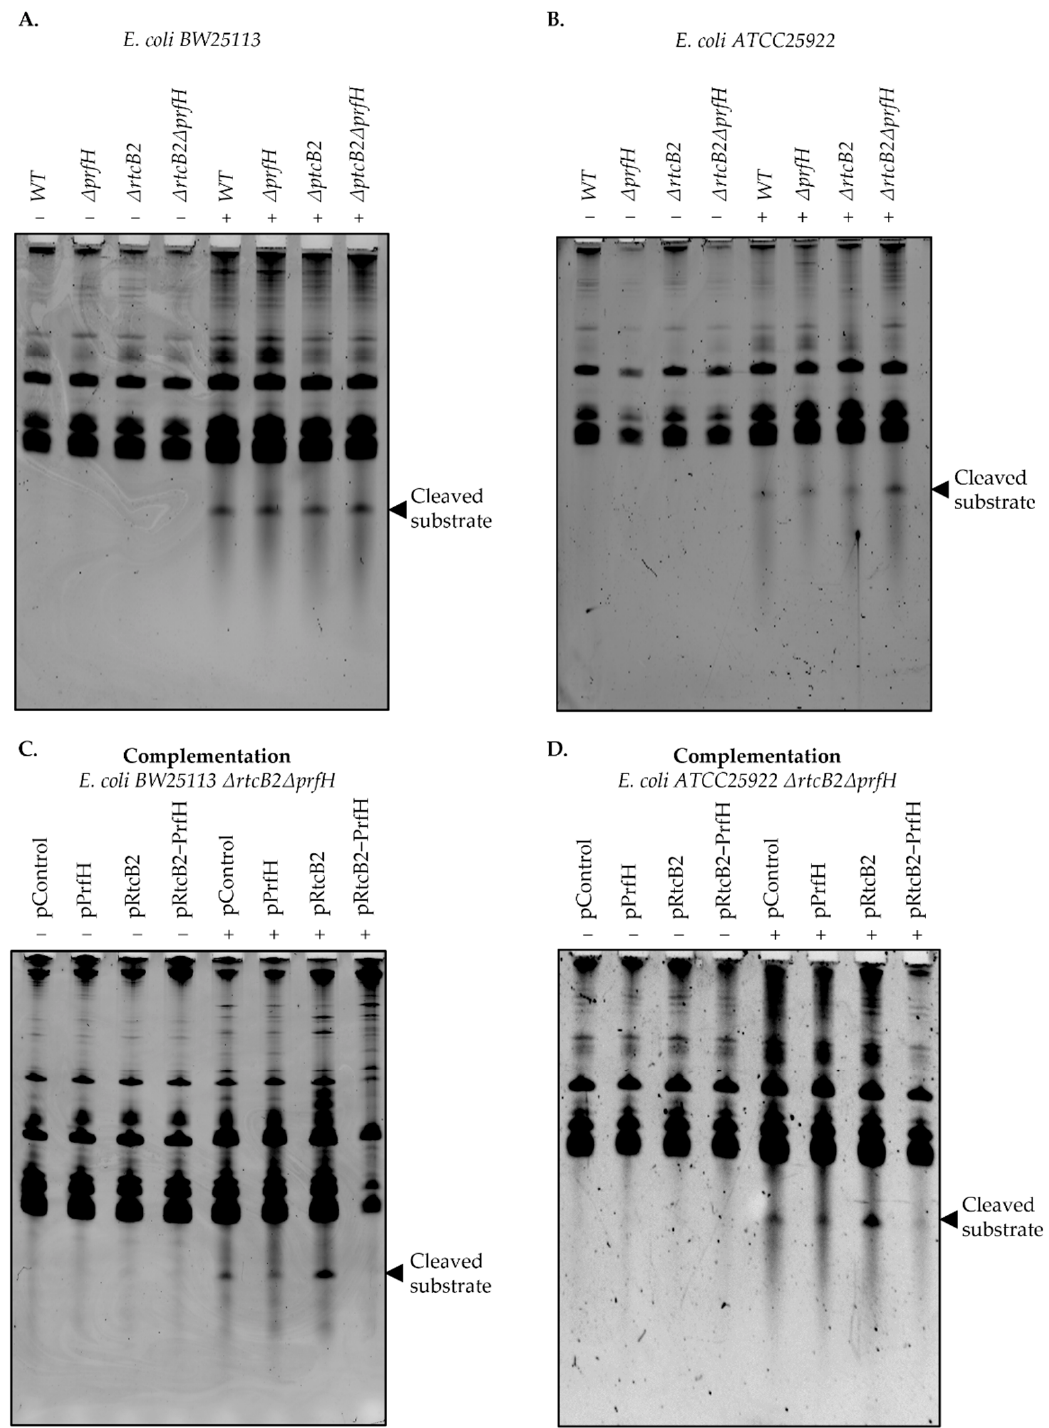
Figure 2. In vivo rRNA cleavage upon colicin E3 treatment. Electrophoretic separation of the in vivo 16S rRNA colicin E3 cleavage fragments for wild-type and knockout strains shown in ( A , B ), including complementation ( C , D ) of the double knockouts genotypes bearing single or both, rtcB2 - prfH , gene(s). Bacterial cells untreated/treated with colicin E3 samples were used to isolate total RNA, and the resulting denaturing polyacrylamide gel electrophoresis was used to analyze rRNA fragments generated by the rRNAse. The − and + signs mean untreated and treated samples with either dialysis buffer (Milli-Q ultrapure water) or 1 mg/mL of recombinant colicin E3 protein, respectively. The results were consistent and reproducible on repeat at least twice upon treatment with colicin